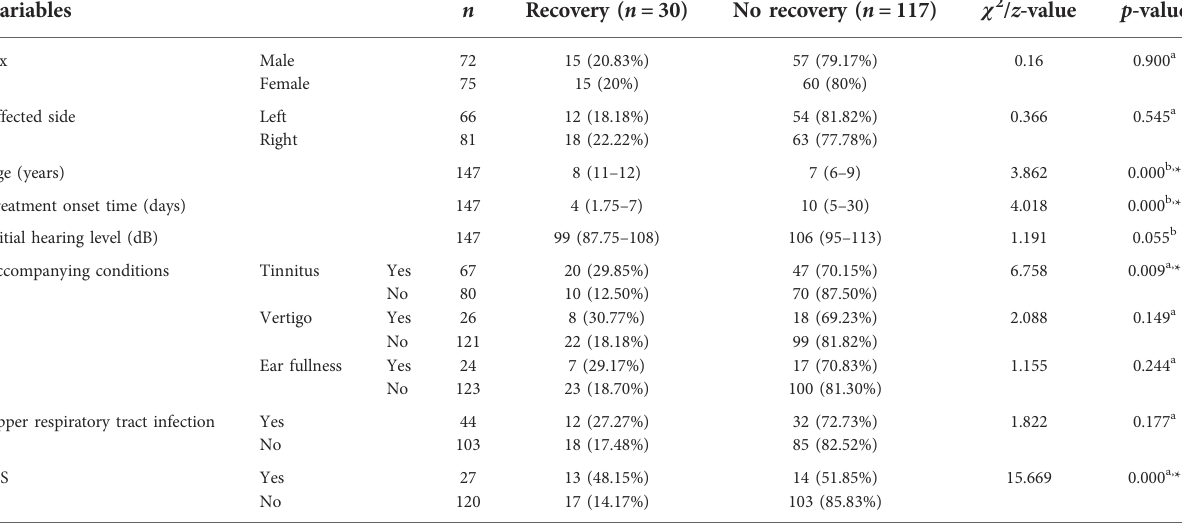
TABLE 3 Univariate analysis of the prognosis of children with profound sudden sensorineural hearing loss.